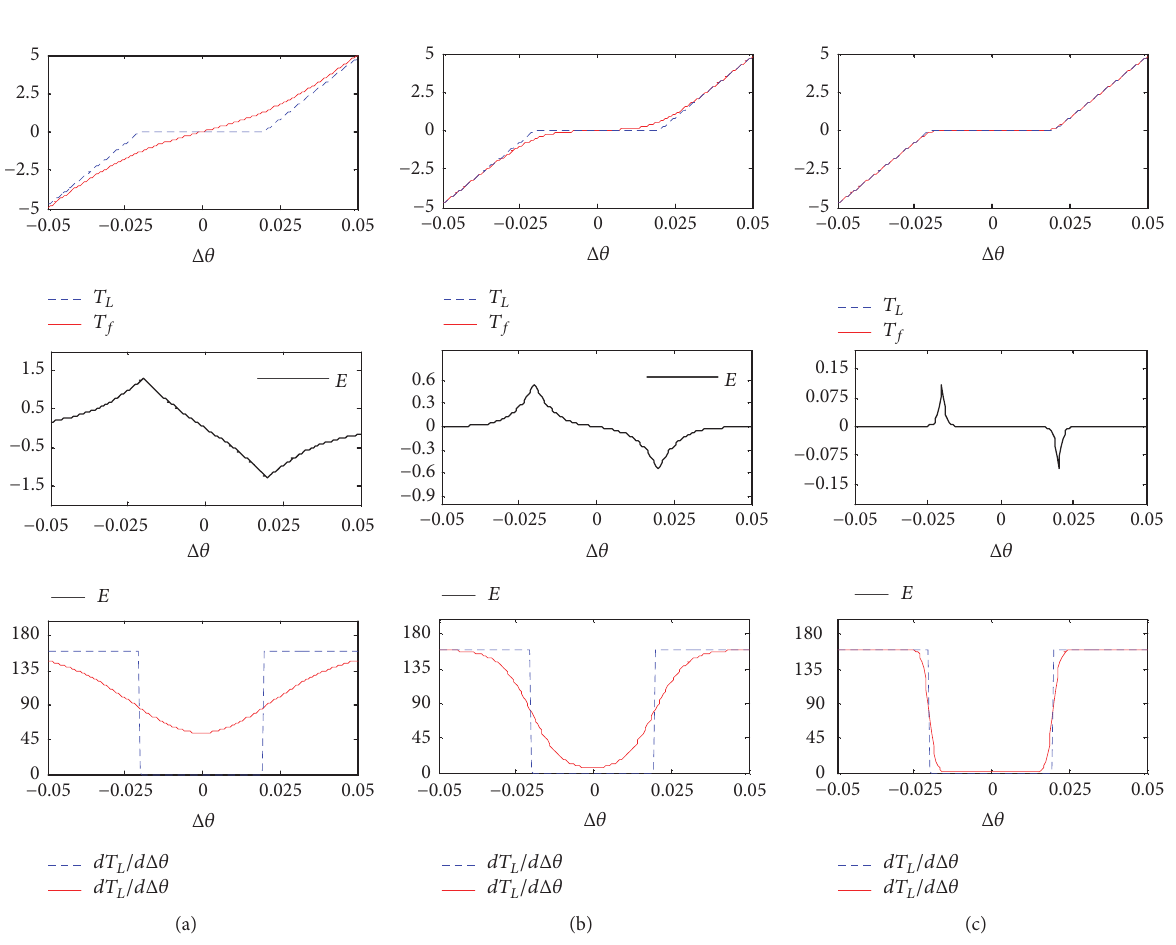
Figure 1: Approximation of dead-zone with different smooth degrees: 𝑘 𝑇 = 160 , 𝛼 = 0.02 . (a) ℎ = 40 , (b) ℎ = 100 , and (c) ℎ = 500 .